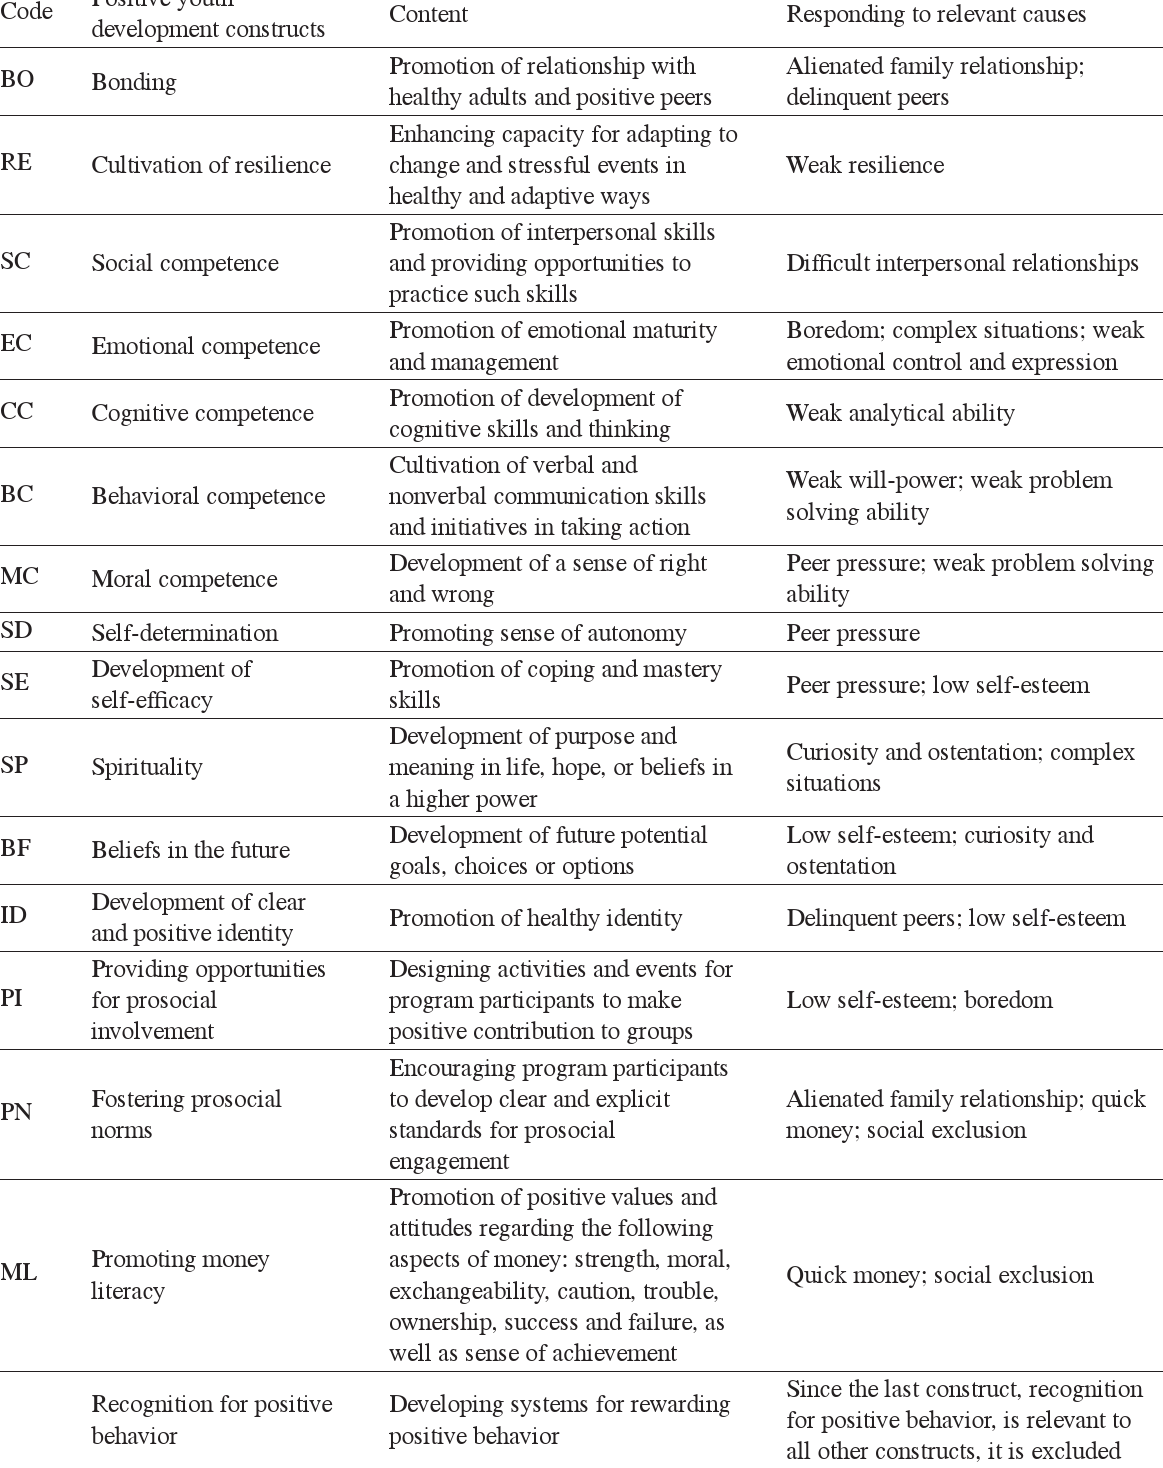
TABLE 1: Dealing with the causes of adolescents’ use of psychotropic drugs through the promotion of 15 positive youth development constructs and money